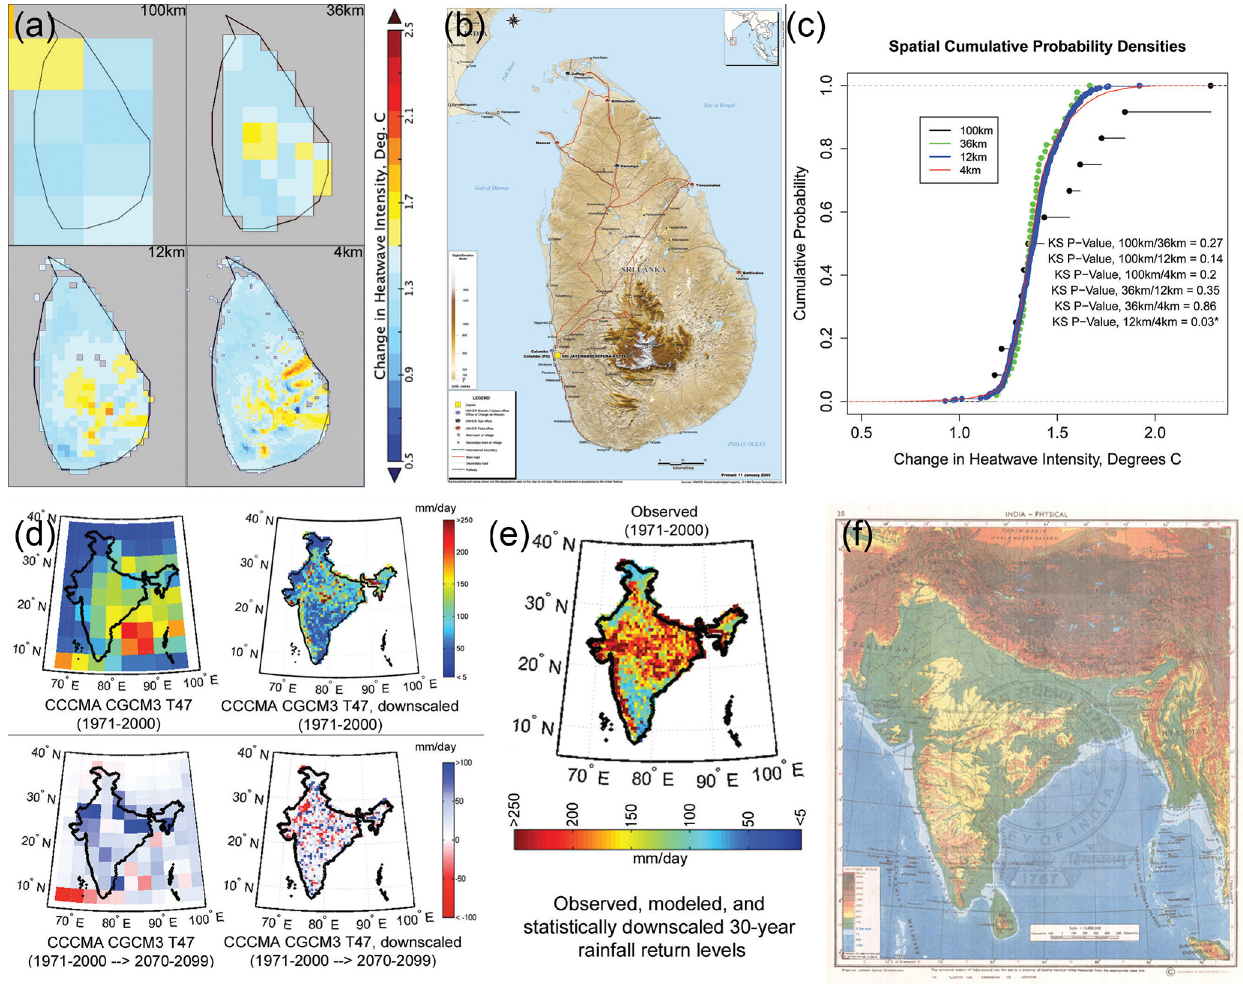
Figure 4. Precise projections with downscaling generate bigger data. (a) – (c) An example of dynamical downscaling that shows changes in heat wave intensity over Sri Lanka from 2006–2015 to 2056–2065 projected by the Community Climate System Model Version 4 (CCSM4) at 100km spatial resolution and dynamically downscaled by the Weather Research and Forecasting (WRF) model at three successively enhanced spatial resolutions: 36, 12, and 4km. Dynamical downscaling yields significant computational challenges. A goodness-of-fit comparison, via the Kolmogorov–Smirnov (KS) tests (c), does not yield substantial evidence for differences in spatial distributions of model runs, which is probably owing to small sample sizes for the 100km and 36km resolution data. However, the effects of topography in the mid-southern Sri Lanka appear more prominent at higher resolutions. The sheer size of the newly generated dynamically downscaled simulations, as well as the problem complexity, further intensifies the need for big data solutions. (d) – (f) Statistical downscaling is complementary to dynamical downscaling and usually requires significantly fewer computational resources. Here we perform statistical downscaling by relating fine- resolution rainfall observations with a large set of climate model-simulated variables and using the relation first to validate on unseen data and then for precise projections in the future. The results show how an ensemble of five runs of the Canadian Centre for Climate Modelling and Analysis (CCCMA) Coupled Global Climate Model 3.1 (CGCM3.1). T47 GCM is validated for 20th century simulations (top two maps in d ), and then applied to the Special Report on Emissions Scenarios (SRES) A2 scenario for 2070–2099 (bottom two maps in d ). Geographical heterogeneity in the trends of rainfall extremes over India, shown in a recent observation-based study, is suggested after downscaling but not directly from the global model runs (Ghosh et al.,